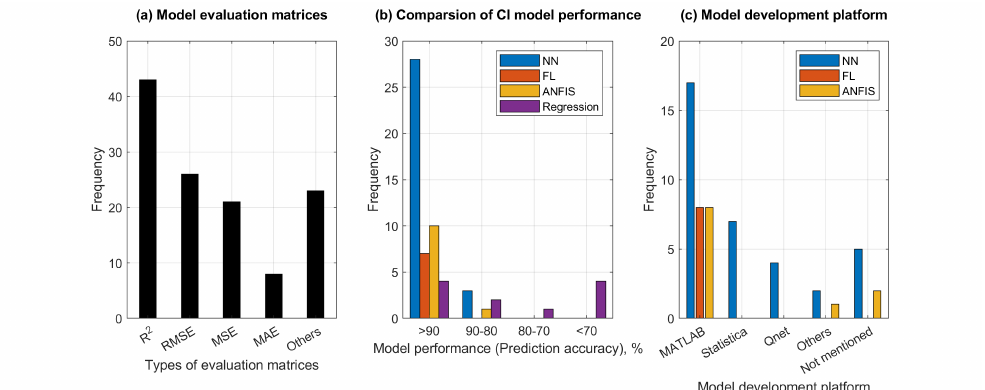
Figure 17. CI models: ( a ) evaluation metrics, ( b ) performance comparison, and ( c ) development